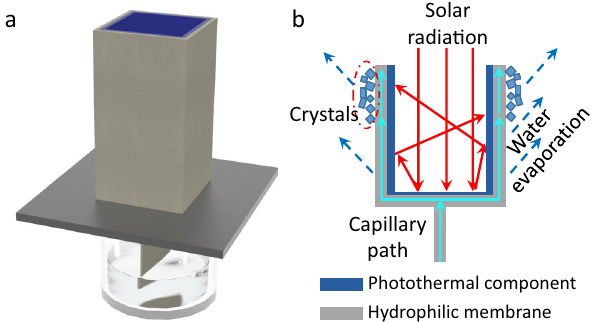
Fig. 1 Schematic illustration of solar crystallization device. a A scheme of the solar crystallizer; b schematic of cross section view of the solar